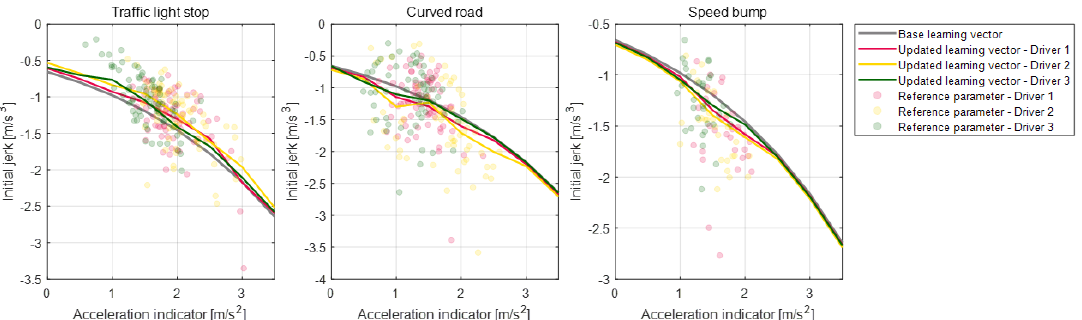
Figure 22. Learning results for parameter initial jerk for each road object.